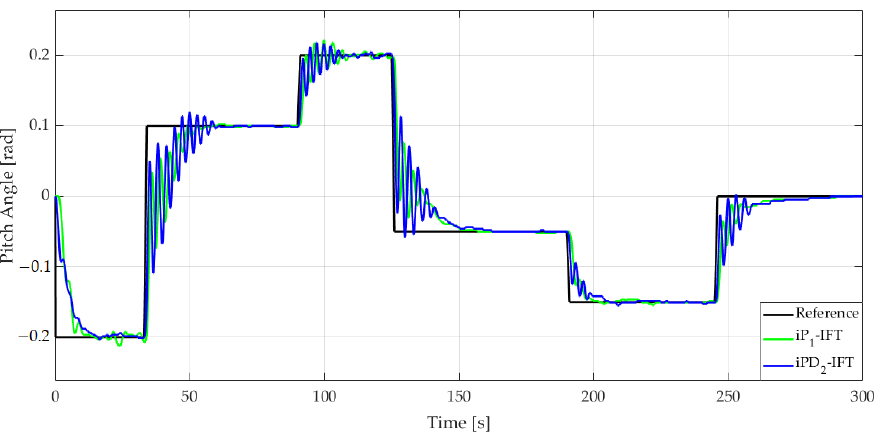
Figure 11. Comparison between the iP 1 -IFT and iPD 2 -IFT controllers for the pitch angle variation experiments.